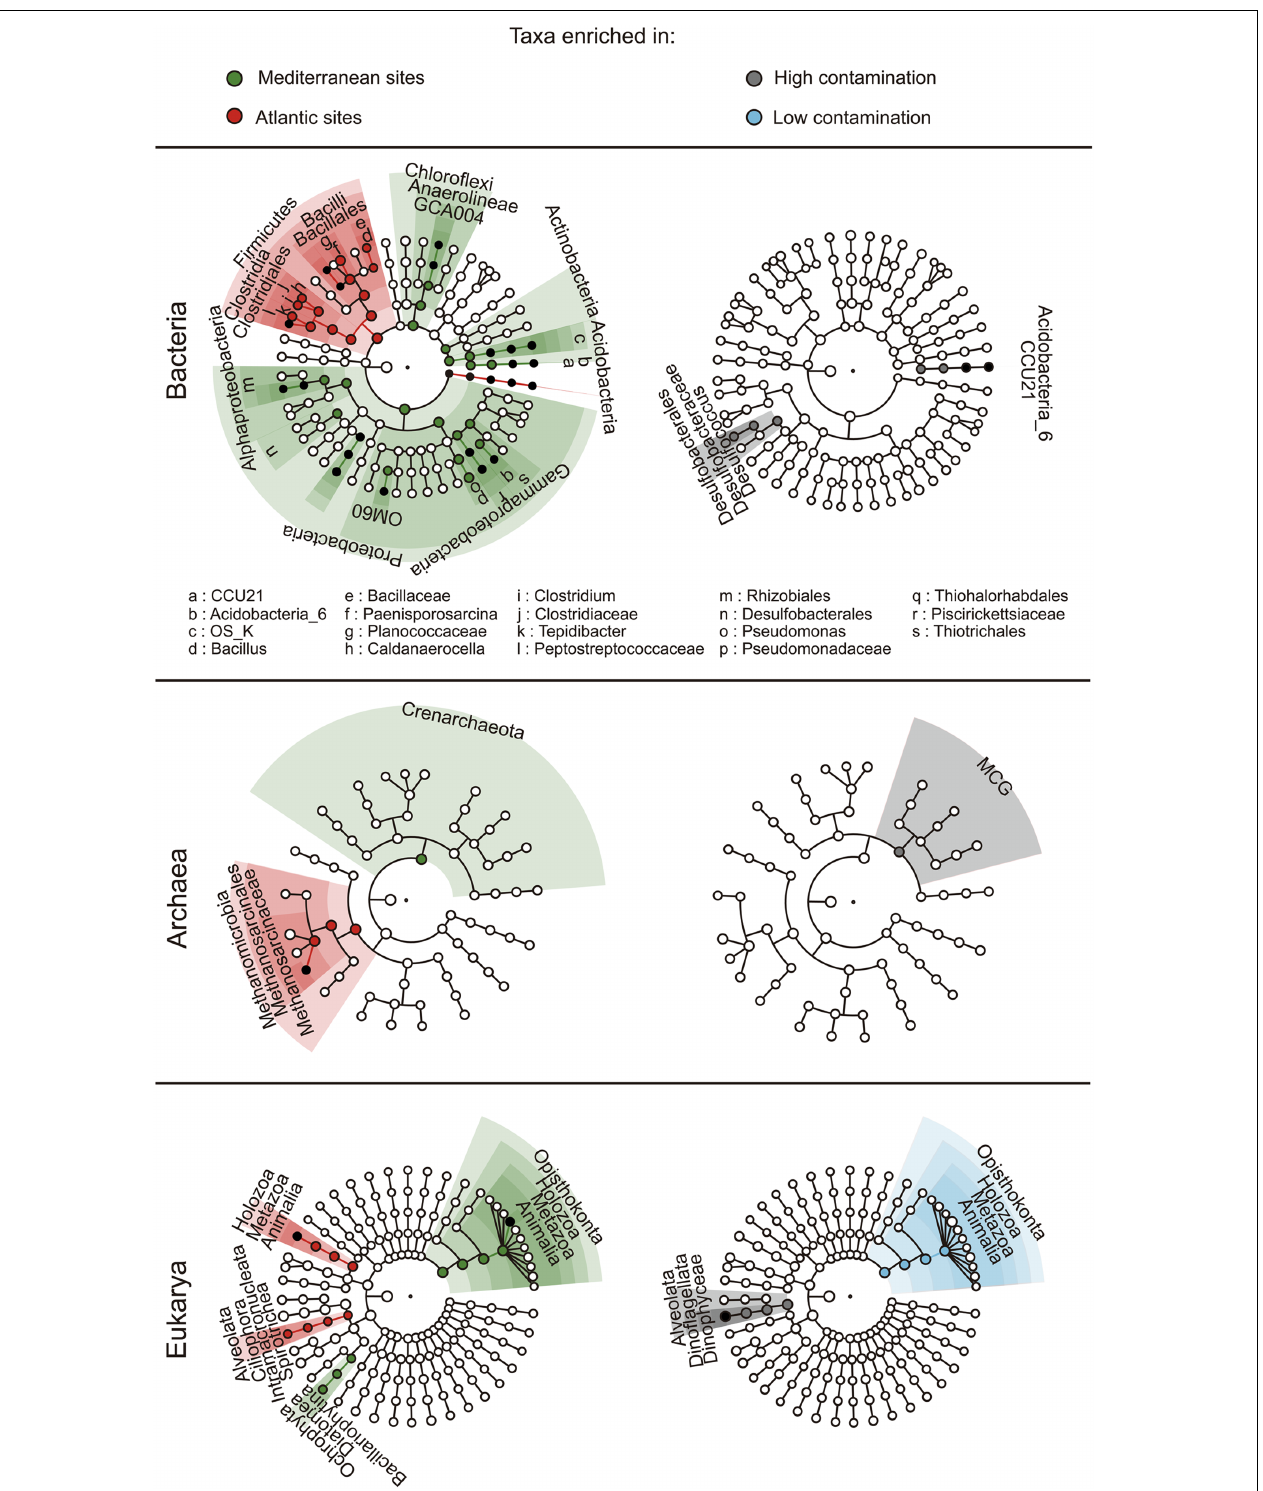
FIGURE 5 | LefSe analysis of the geographic origin (left panel) and the level of contamination (right panel). The cladograms show taxa enriched (i.e., with significant differential abundance) within the environmental groups of samples (i.e., Mediterranean Sea and Atlantic; high and low contamination levels). The roots of the cladograms stand for the domain, and concentric circles represent the following taxonomic levels until the tips standing for genera. Biomarkers are shaded according to the groups of samples. The dot diameter is proportional to the abundance of the corresponding taxa.